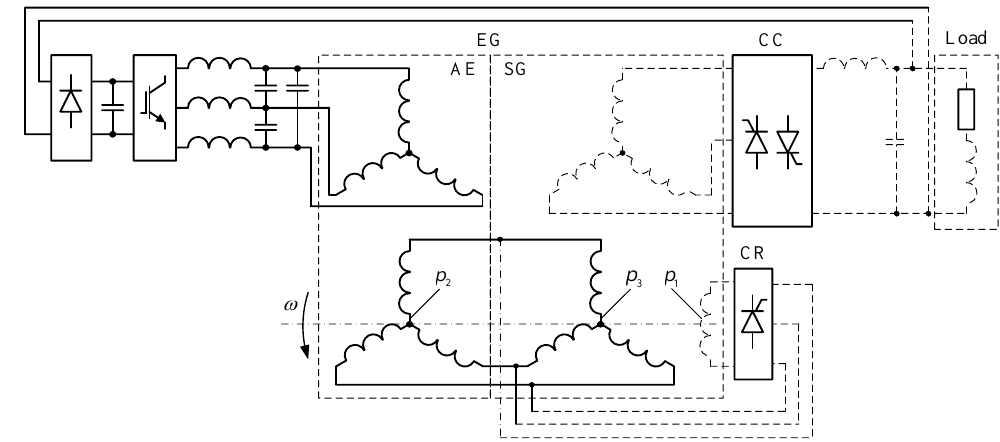
Figure.1. Functional diagram of autonomous single-phase voltage source of stable frequency with shaping the output voltage waveform of electric